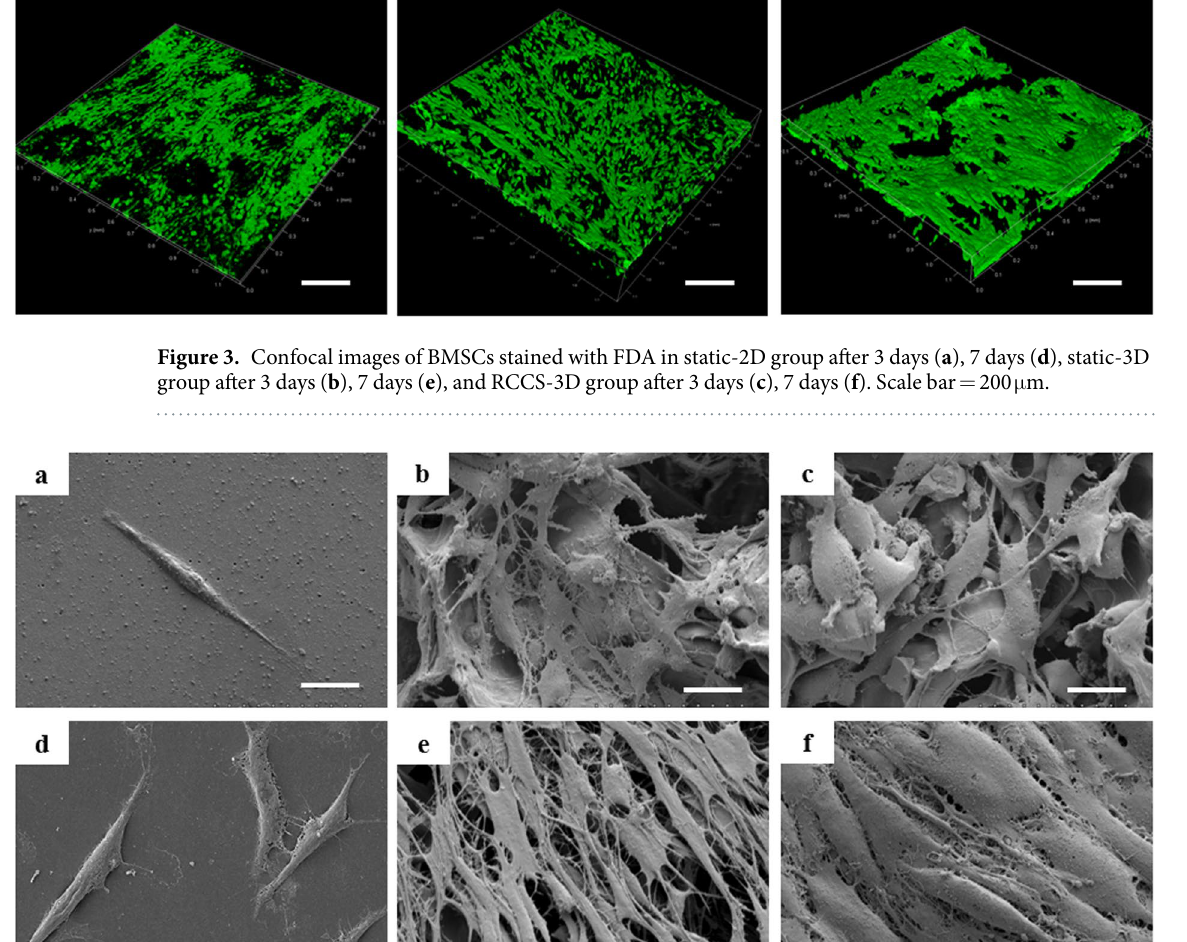
regulation of apoptosis, and regulation of cell proliferation, etc. (Fig. 6b). And we can also see the results of the terms based on most significant p value in cellular component differential genes analysis and the transcriptional